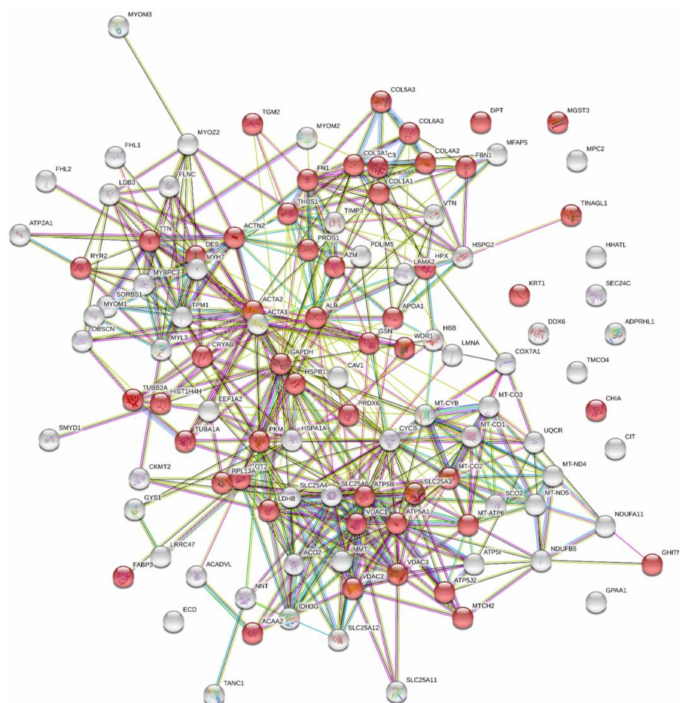
Figure 1. STRING analysis depicting hgECM proteins identified by MS. A total of 113 proteins were identified in the hgECM, of which 51 belong to the ECM region (red spheres). Lines indicate known protein interaction from curated databases (turquoise) and experimentally determined (pink), predicted interactions for gene neighborhood (green), gene fusion (red) and gene co-occurrence (blue). Other connections indicate text mining (yellow), co-expression (black) and protein homology (light blue). Detailed information on identified proteins is provided in Table